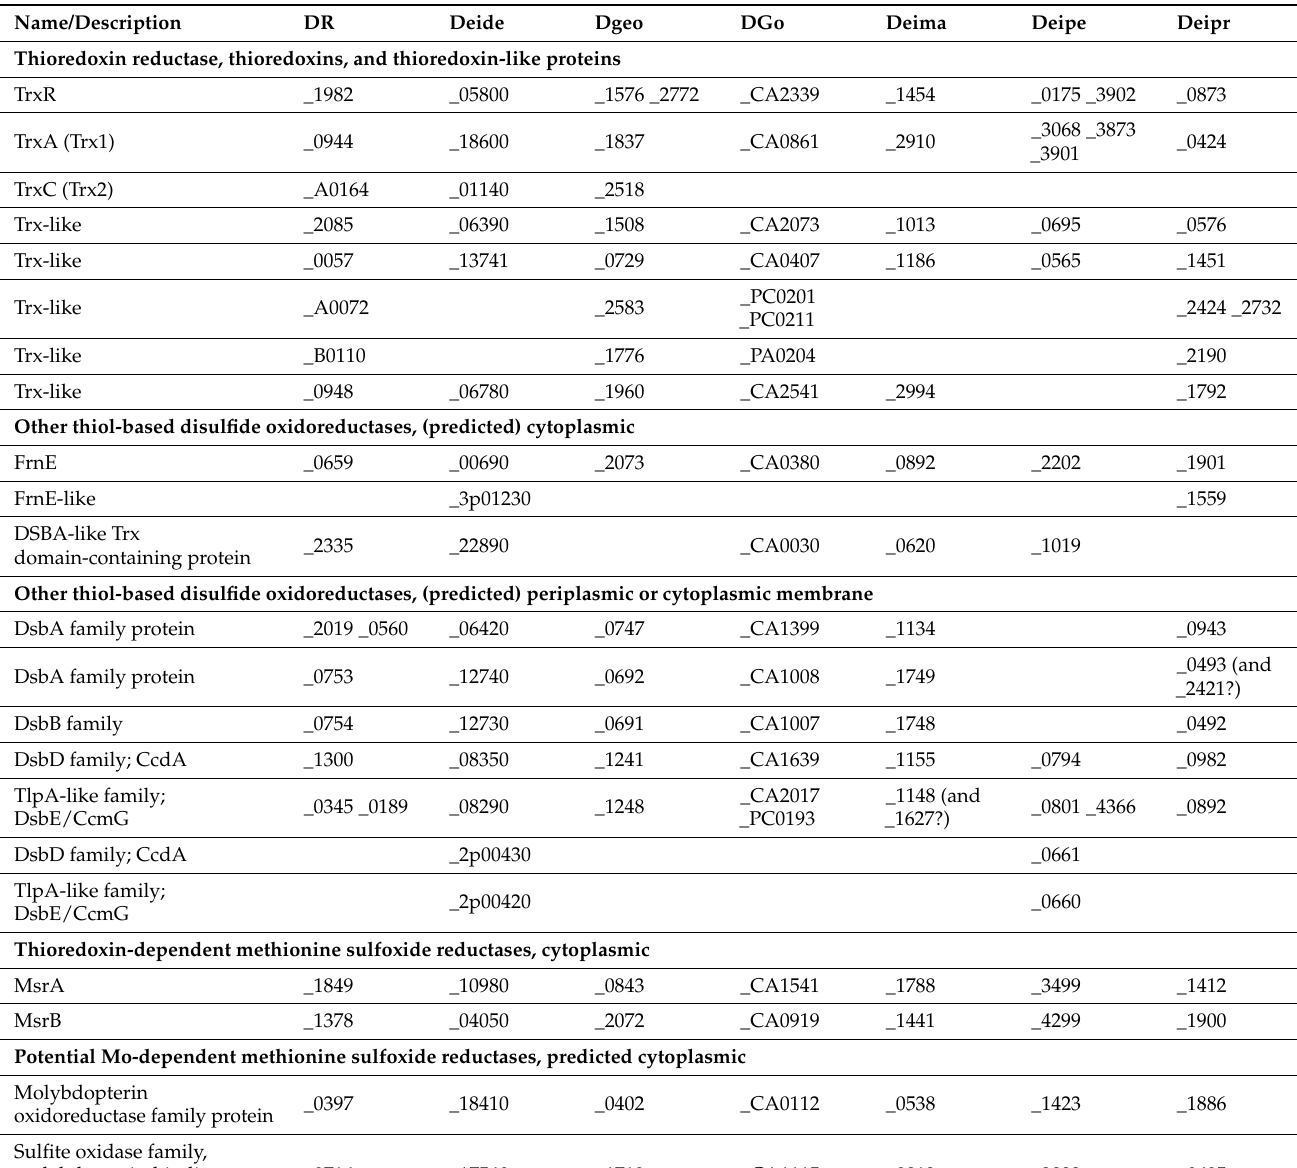
Table 2. Locus tags of genes encoding thiol reductases and related proteins from seven Deinococcus